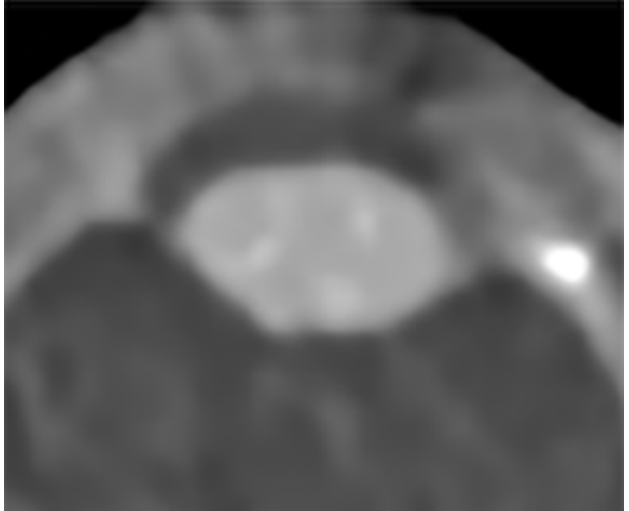
Figure 2. Axial non-contrast DECT image zoomed for lens detail. An 84-year-old lens demonstrates a “speckled” appearance—with scattered punctate foci of increased attenuation. This pattern of spatial heterogeneity raises the question of whether texture analysis may be a more useful method of assessing for cataract at CT.